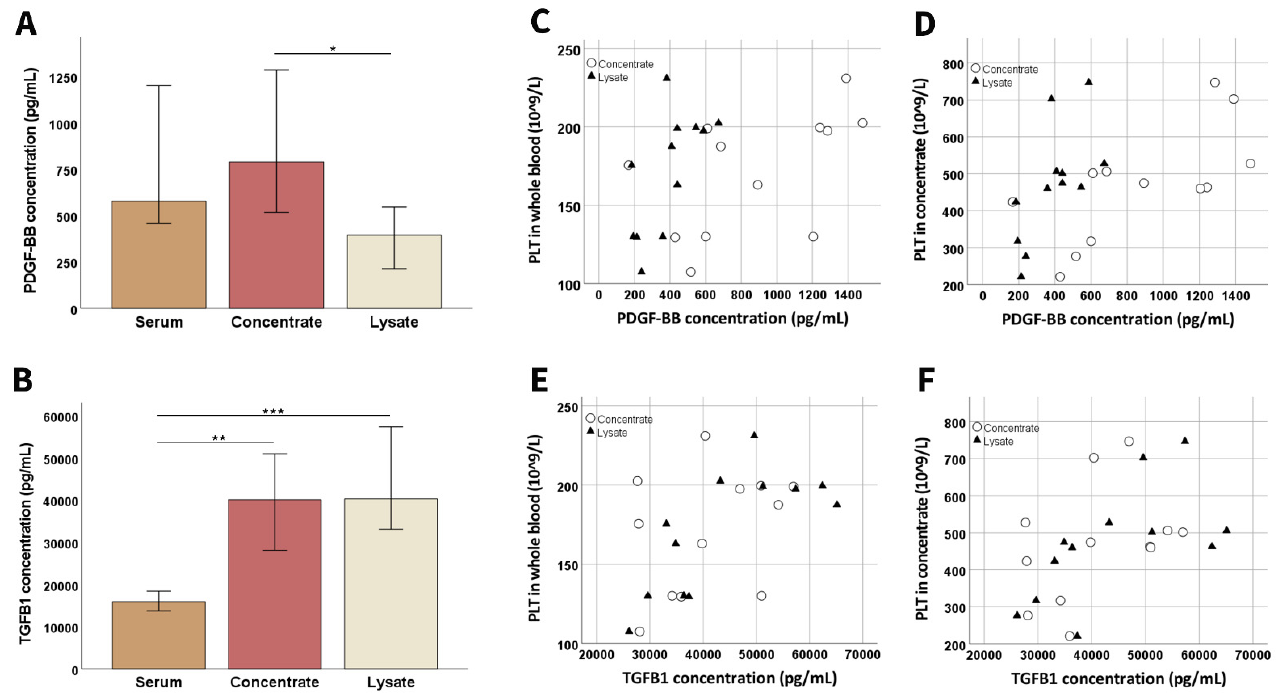
Figure 2. Growth factor concentrations during blood processing. Median platelet-derived growth factor (PDGF-BB; ( A )) and transforming growth factor- β 1 (TGFB1; ( B )) concentrations at the different stages of blood processing (whole blood, concentrate, and lysate before filtration; samples had been stored at − 80 °C before analysis) are presented; error bars display the 95% confidence intervals. Friedman tests for group comparisons and subsequent post hoc tests were performed; the asterisks indicate the significant differences between the corresponding groups (* corresponds to p < 0.05; ** corresponds to p < 0.01; *** corresponds to p < 0.001). The dot plots show platelet (PLT) concentrations in whole blood ( C , E ) or concentrate ( D , F ) vs. PDGF-BB ( C , D ) or TGFB1 ( E , F ) concentrations in concentrate (circles) and lysate (triangles); the correlations shown in ( C ) ( p < 0.01 and r = 0.729 for concentrate; p < 0.05 and r = 0.641 for lysate), ( D ) ( p < 0.01 and r = 0.804 for concentrate; p < 0.01 and r = 0.748 for lysate), ( E ) ( p < 0.05 and r = 0.676 for lysate), and ( F ) ( p < 0.05 and r = 0.671 for lysate) were significant based on Spearman’s rank correlation. All data were obtained from n = 12 dogs.